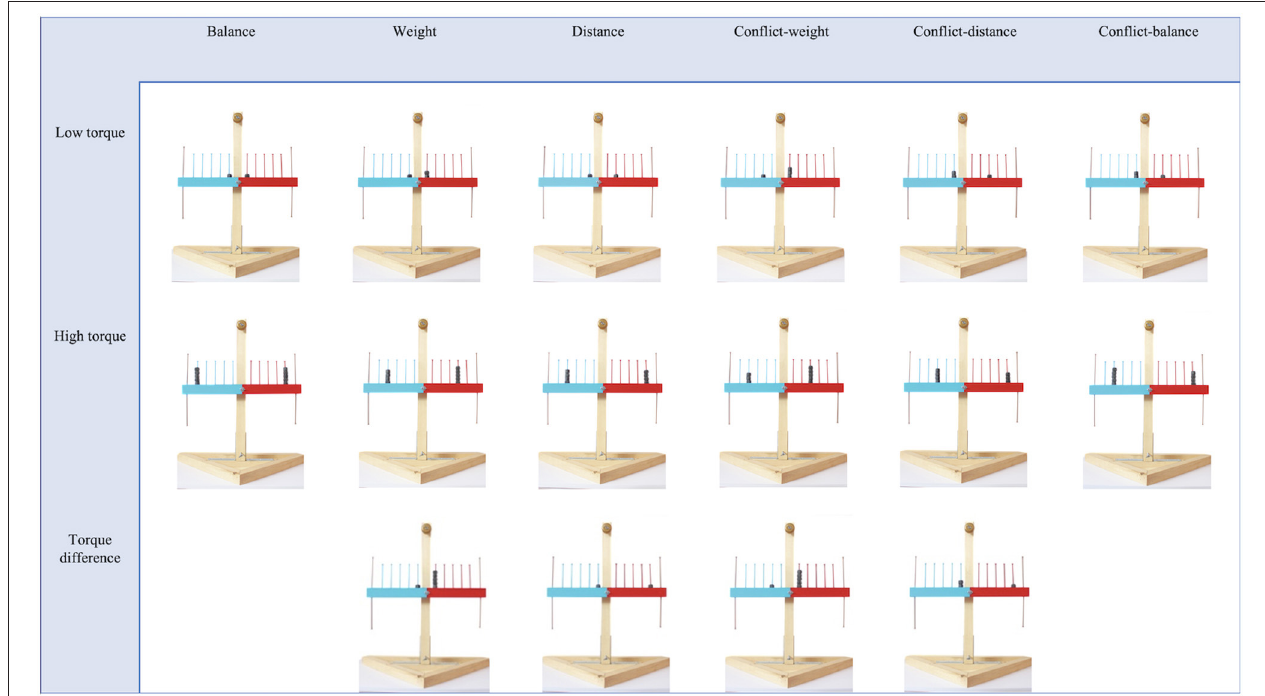
FIGURE 1 | Balance-scale task